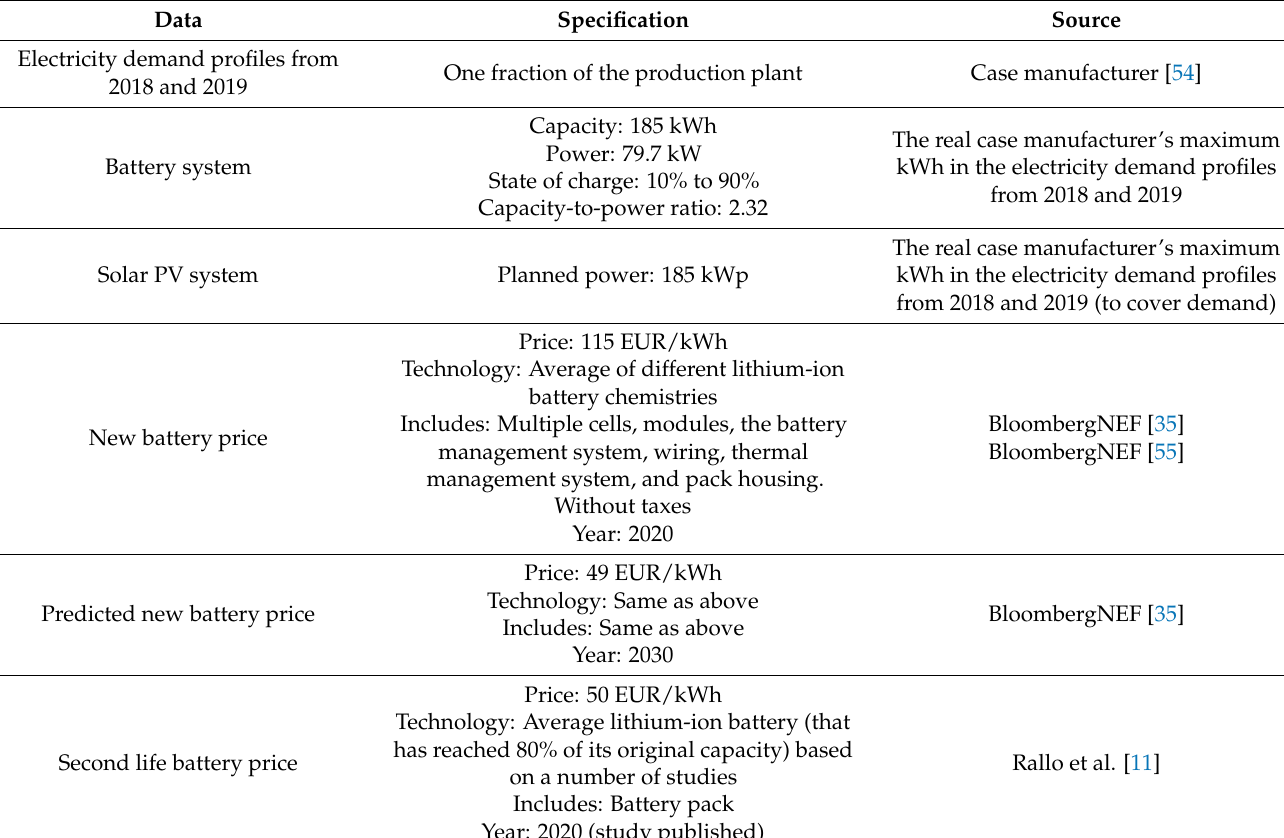
Table 2. Data specification and